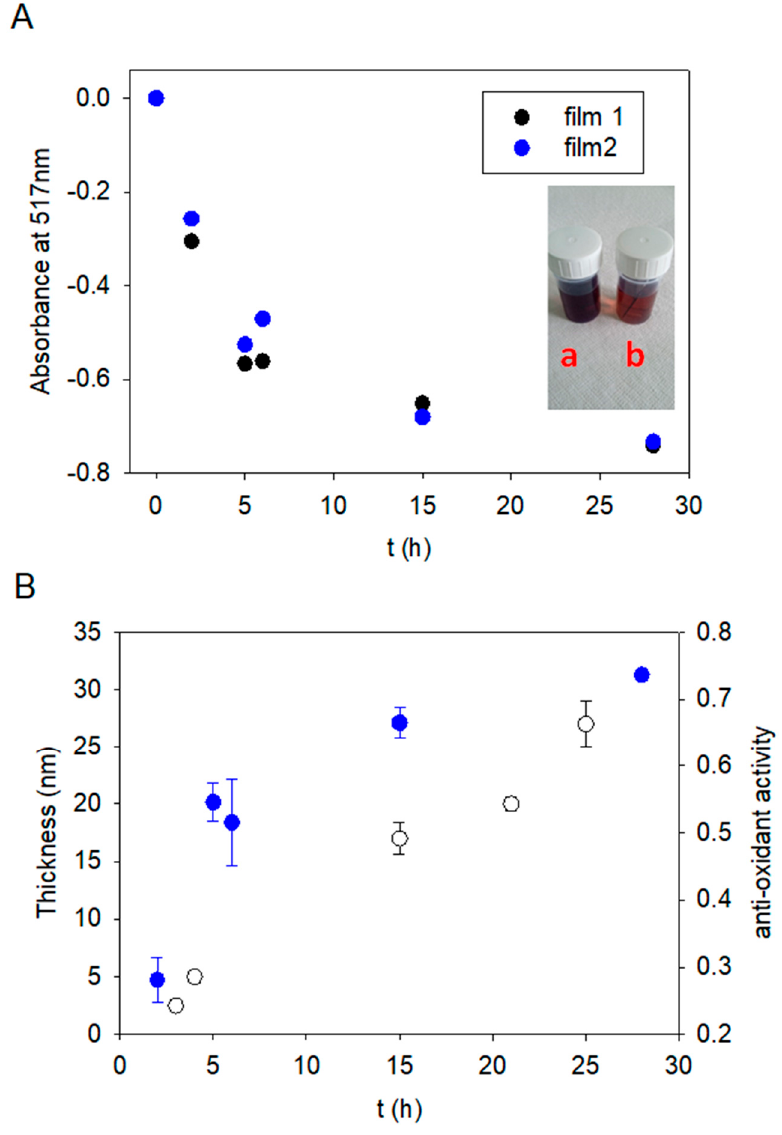
Figure 5. ( A ) Evolution of the absorbance at 517 nm of a 2,2-diphenyl-1-picrylhydrazyl (DPPH) solution (10 − 4 M in ethanol) put in contact for 30 min with an AMN film deposited on glass for the indicated duration. The picture corresponds to a DPPH solution kept in the dark (reference, picture a) and a DPPH solution kept in the dark but in contact with an AMN based film deposited for 5 h on a glass slide (picture b). 2 individual measurement series were performed ( • , • ). ( B ) Evolution with time of the AMN-based film thickness (same data as in Figure 1, left hand scale) and their anti-oxidant activity (taken as the average ± one standard deviation (SD) from the data in part A, right hand scale). Reproduced with permission from [14], Copyright Elsevier, 2020.